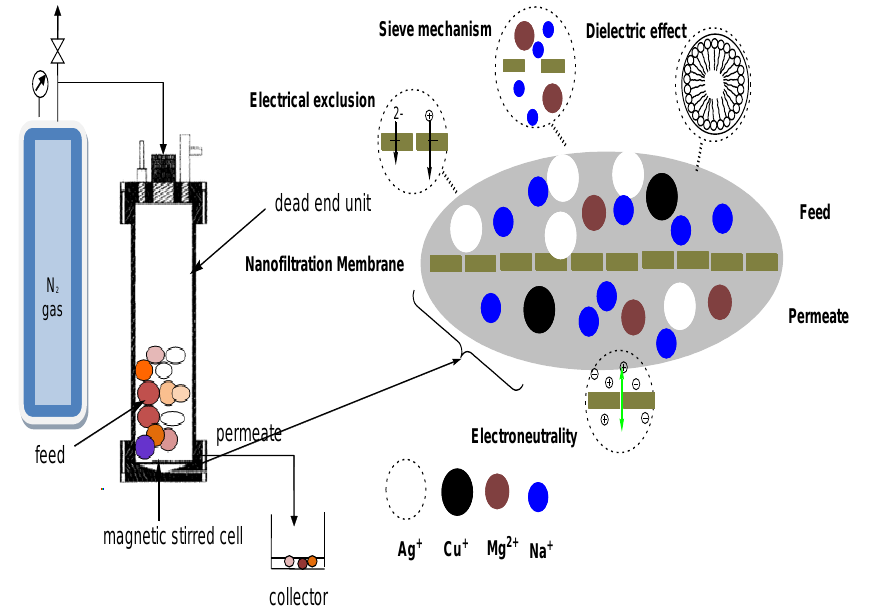
Figure 1. Nanofiltration separation mechanism.